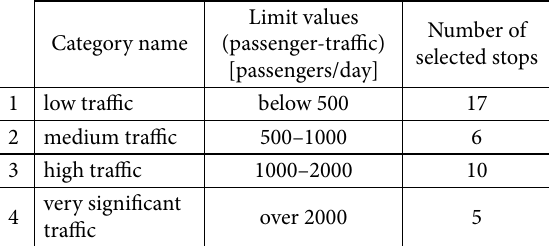
Table 4. Stop categories according to the volume